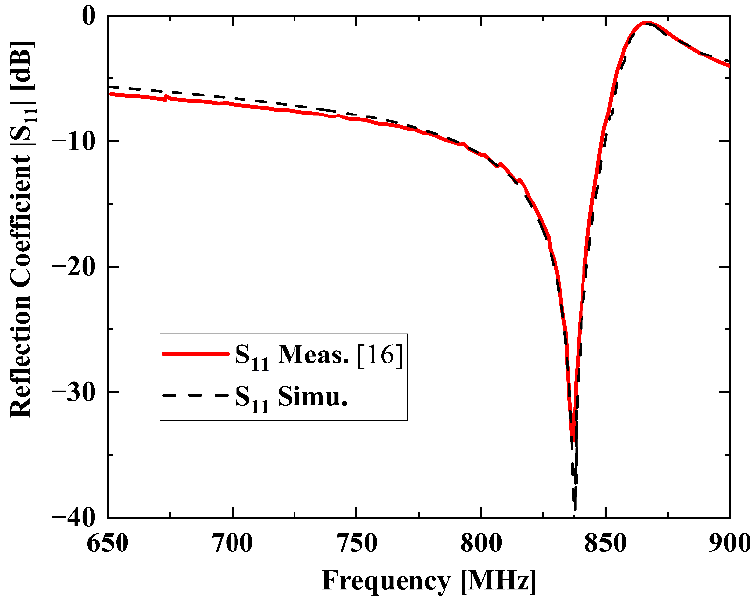
Figure 3. Measured and simulated reflection coefficient 𝑆 11 of the SAW resonator.